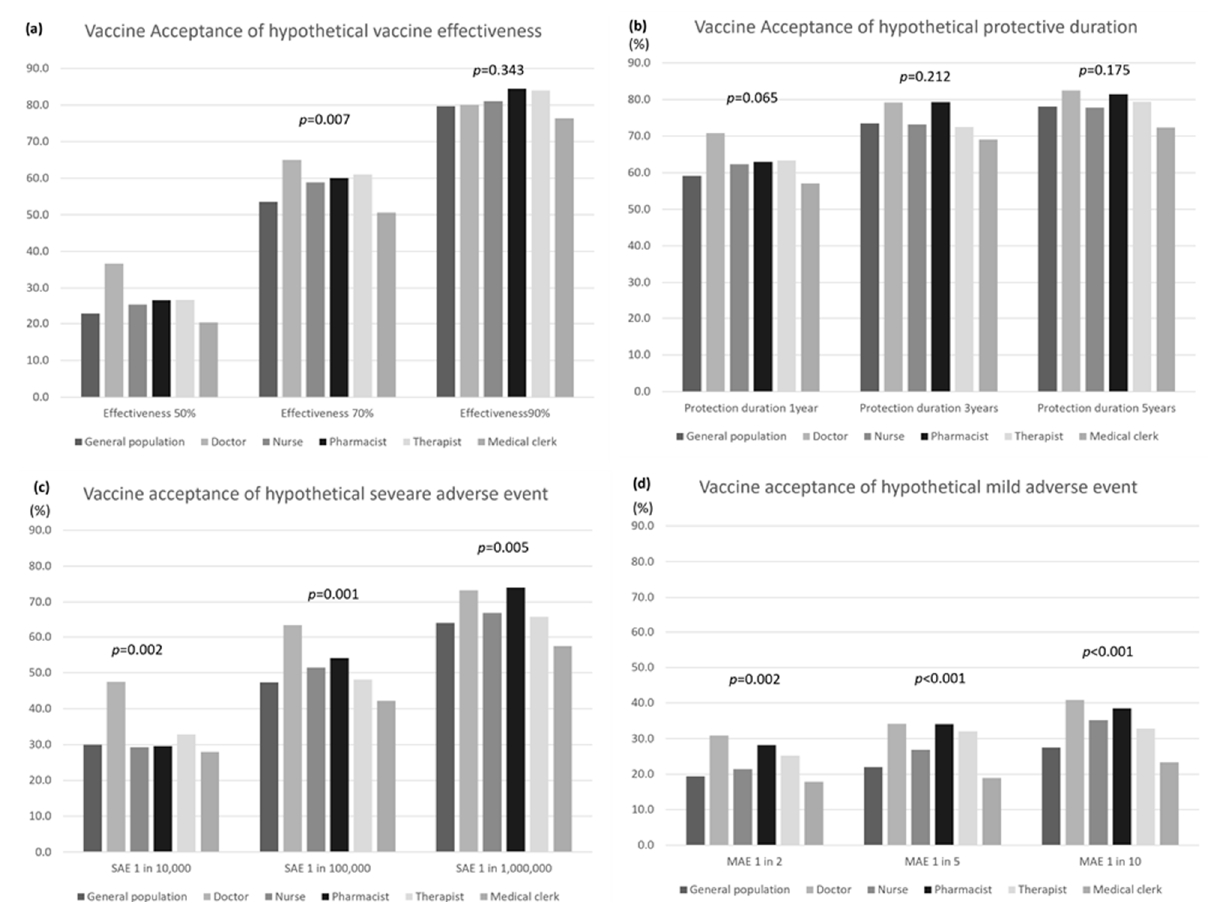
Figure 1. COVID-19 vaccine acceptance under hypothetical vaccine effectiveness, duration of effectiveness, and frequency of adverse events. ( a ) Vaccine acceptance under hypothetical vaccine effectiveness; ( b ) vaccine acceptance under hypothetical durations of effectiveness; ( c ) vaccine acceptance under hypothetical frequency of severe adverse events (SAE); ( d ) vaccine acceptance under hypothetical frequency of mild adverse events (MAE).